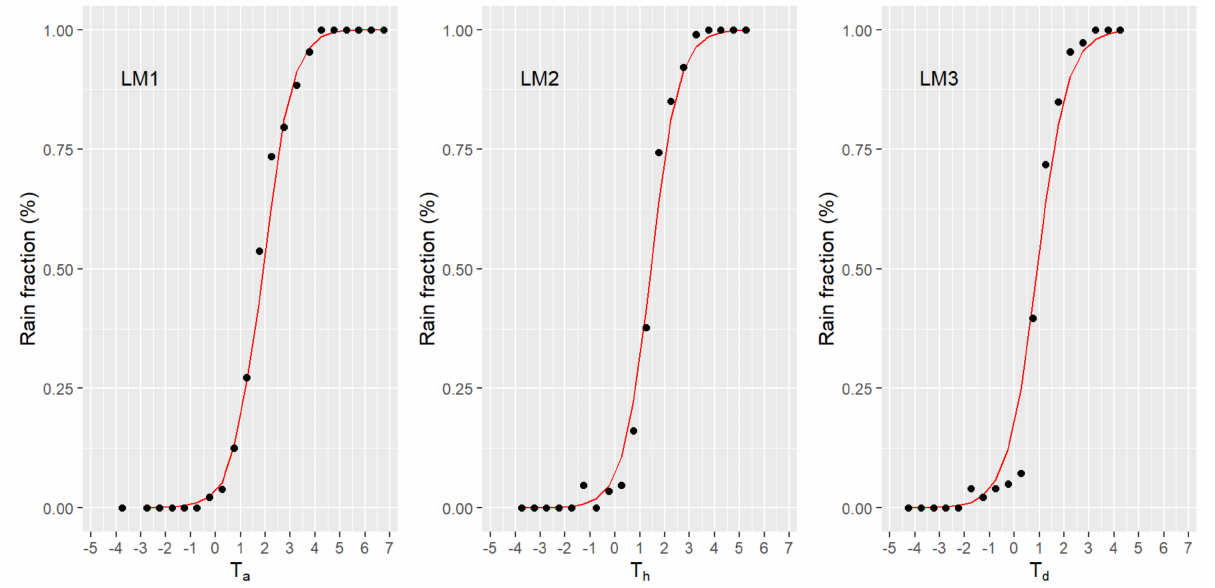
Figure 6. Precipitation phase plots using logistic models. From left to right. LM1 depends on Ta and RH ( left ). LM2 depends on Th ( center ). LM3 depends on Td ( right ). The black points represent observed values, and the red lines represent simulated